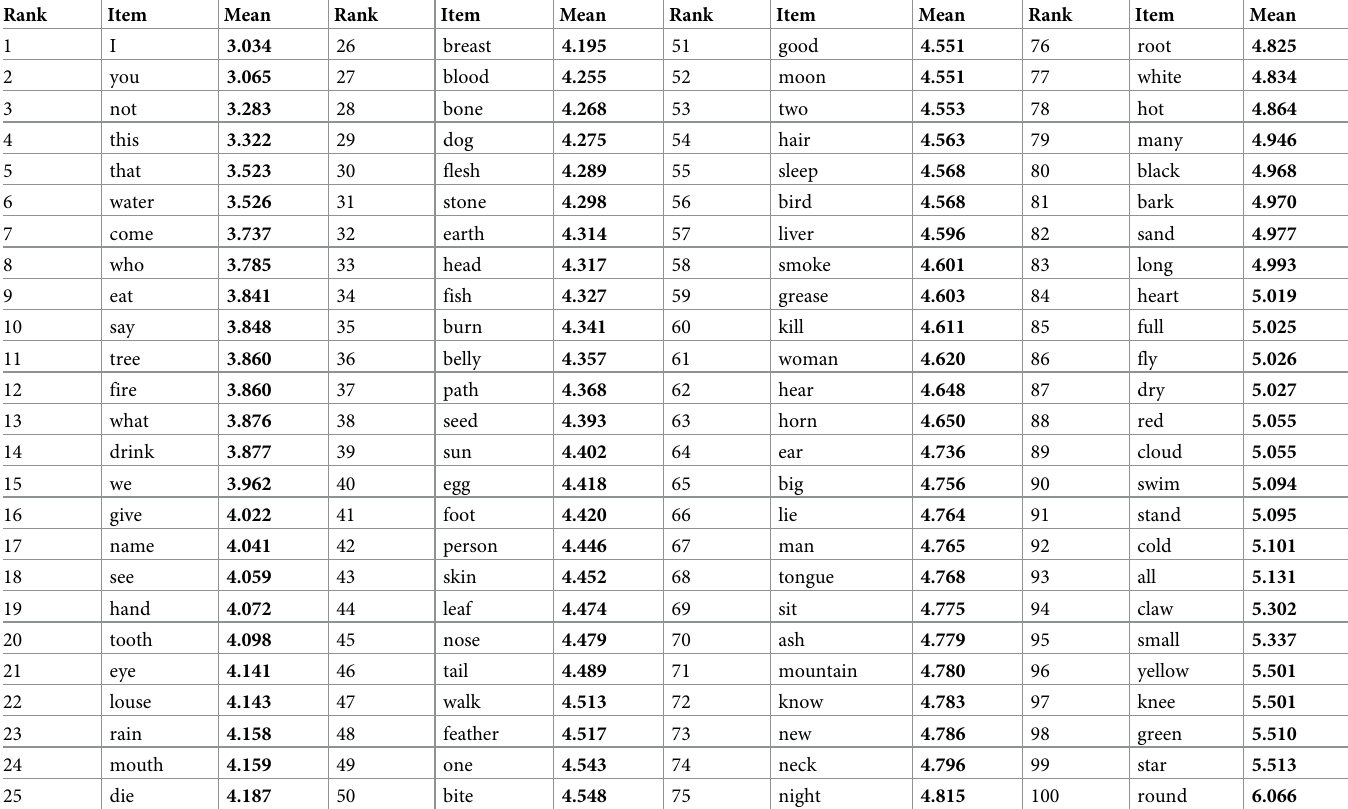
Table 2. Mean word length for items aggregated over WALS